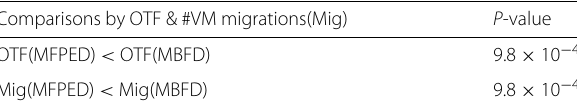
Table 8 Statistical test for the significance of OTF and #VM migrations improvement by the proposed MFPED algorithm Comparisons by OTF & #VM migrations(Mig) P